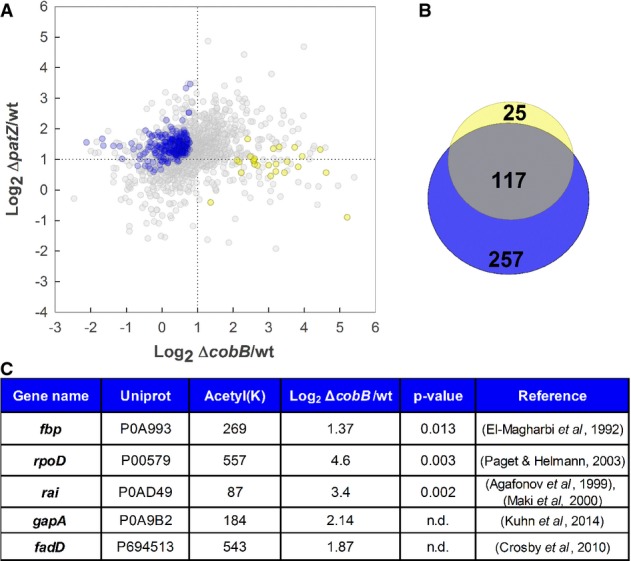
Differential protein acetylation in patZ and cobB mutants
in acetate culturesRepresentation of the log2 acetylation ratio for ΔpatZ/wt
(y-axis) and ΔcobB/wt (x-axis) of peptides
in acetate cultures. Values used were obtained from four biological replicates (n
= 1,875 different acetylated peptides detected). Peptides with significantly different ratios
in the patZ and cobB mutants are colored in blue and yellow,
respectively (two-sample t-test, adjusted for multiple testing using
permutation-based FDR < 0.05).Venn diagram showing the overlap of significant acetylated peptides with an acetylation ratio
compared with the wild-type strain higher than 2 (FDR < 0.05). In blue are represented the
number of significant acetylated peptides of ΔpatZ and in yellow those for
ΔcobB mutant. The overlapping grey region represents those peptides which
are significantly acetylated in both mutants.Representative examples of proteins acetylated in the ΔcobB mutant in
acetate cultures, but not altered in the patZ mutant, whose function is probably
affected. Further information is detailed in the main text and in the Supplementary Materials and
Methods.Source data are available online for this figure.